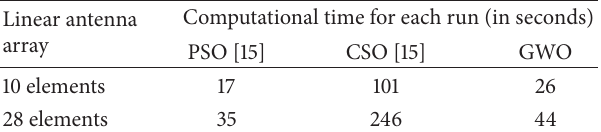
Table 14: Optimized current amplitudes of the positive half of the 10-element array of Example 8 .